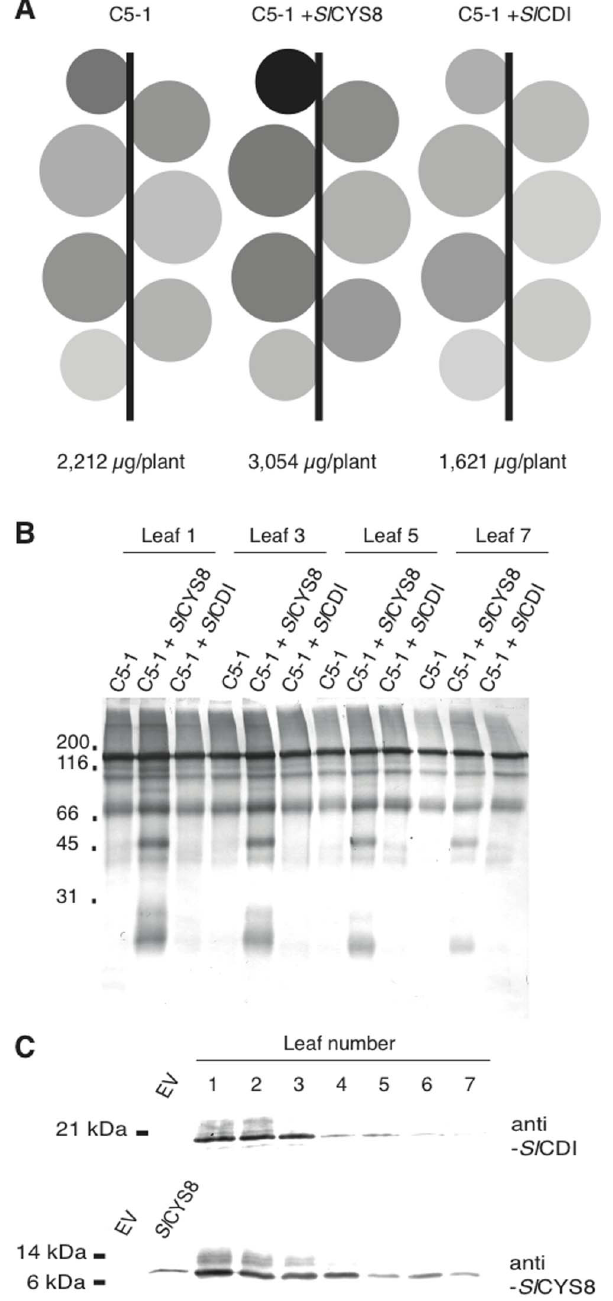
Figure 4. Effect of co-expressed Sl CYS8 or Sl CDI on C5-1 accumulation. (A) Plants are represented as schematic diagrams where the area of each circle represents the weight of the corresponding leaf. Levels of grey are proportional to the amount of C5-1 on a total soluble protein basis, as determined by quantitative ELISA with a murine IgG standard and normalised to the maximum amount obtained. Leaves were infiltrated with the C5-1 expression vector alone or along with Sl CYS8 or Sl CDI expression vectors. Each value is the mean of three independent (biological) replicates. Numbers below each plant indicate mean antibody production level for the whole plant. (B) Immunodetection of C5-1 at 6 dpi in Leaf 1, Leaf 3, Leaf 5 and Leaf 7, expressed either alone or along with Sl CYS8 or Sl CDI. The proteins were detected with alkaline phosphatase-conjugated goat anti-mouse IgG, after SDS-PAGE under non-reducing conditions. (C) Immunodetection of Sl CYS8 and Sl CDI at 6 dpi in Leaves 1 to 7,